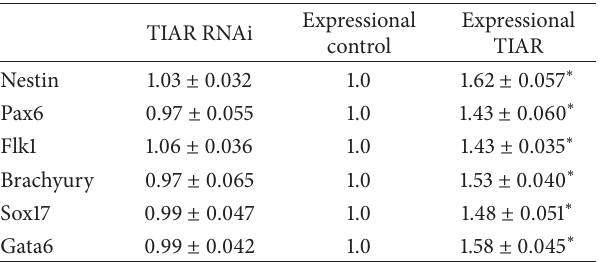
Table2:Geneexpressiononday4EBdifferentiationinrescueTIAR siRNA-treated